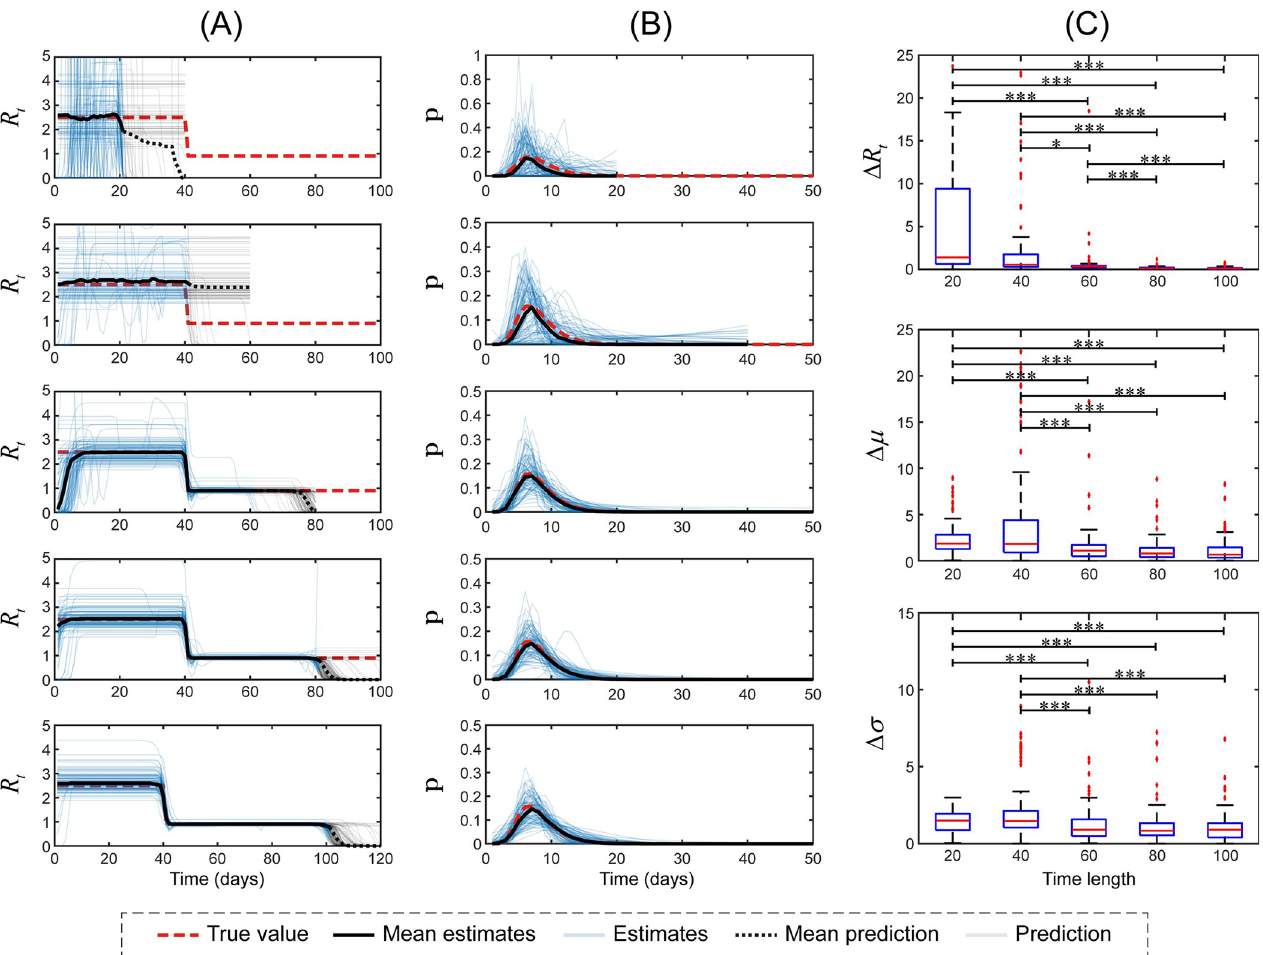
Fig 3. The effects of the time length on the results. A total of 100 trials were conducted to investigate the performance of our method by varying time length (from 20 to 100). Simulations were performed based on the assumptions that the number of initial cases was 2, the serial interval exhibited a lognormal distribution with a mean and variance of 8 and 9, respectively, and a constant R before ( R 1 = 2.5) and after ( R 2 = 0.9) a control measure on day 40. The left, middle and right panels are the estimates of instantaneous reproductive number, the estimates of the serial interval and the results of three indices, respectively. The blue lines show the estimates, and the dark lines denote their mean values under 100 simulations. Additionally, the grey lines denote predictions and dashed dark lines represent their mean values from 100 simulations. The red dashed lines represent the ground truth. * : P < 0.05, and *** : P <